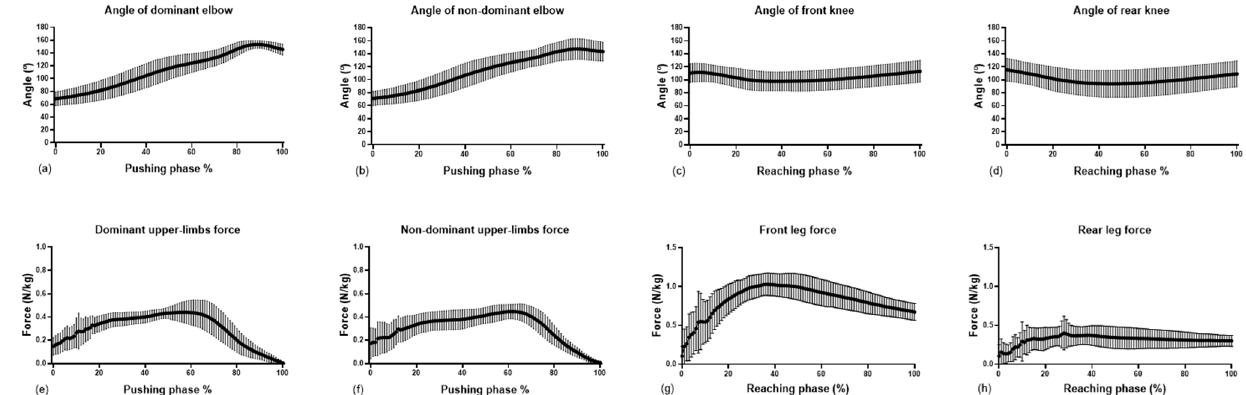
Figure 3. Average and standard deviation of kinematic and force variables during the pop-up. The first line shows ( a , b ) as the dominant and nondominant elbows angle during the pushing phase; ( c , d ) are, respectively, the front and rear knee angle during the reaching phase. On the second line, ( e , f ) show the dominant and nondominant upper-limb ground reaction forces during the pushing phase, while ( g , h ) show the front and rear leg ground reaction forces.